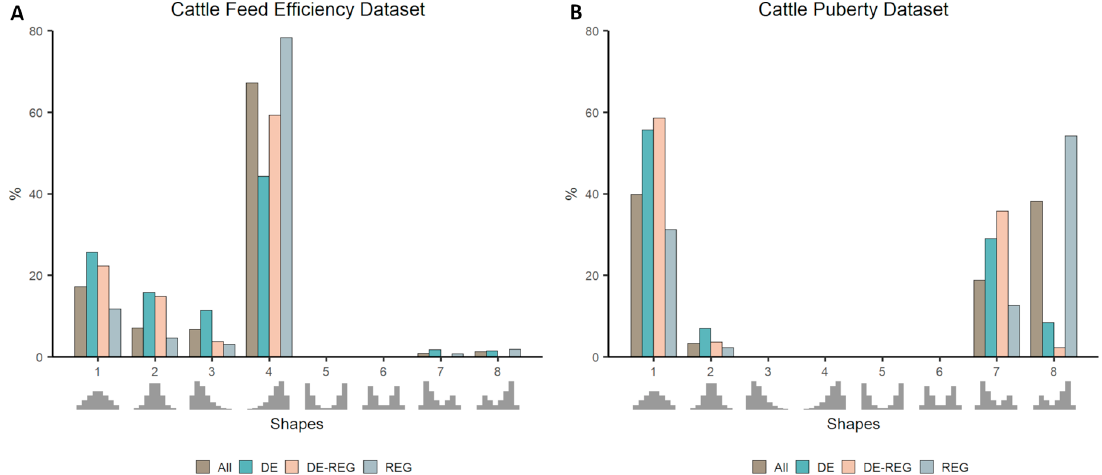
Figure 2. Proportion of genes falling in each template shape in datasets with contrasting phenotypes: cattle feed efficiency ( A ) and cattle puberty ( B ). The proportion of genes classified as differentially expressed (DE), regulator (REG), or both (DE-REG) are compared to the overall (All) proportion of genes within each shape.